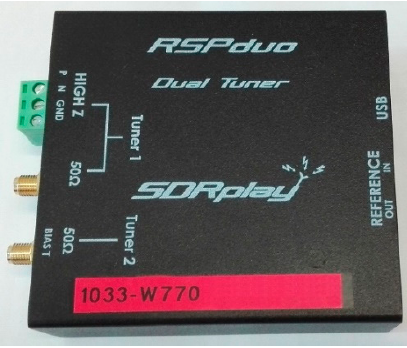
Figure 4. RSPduo: dual-tuner SDR (software-defined radio) receiver.